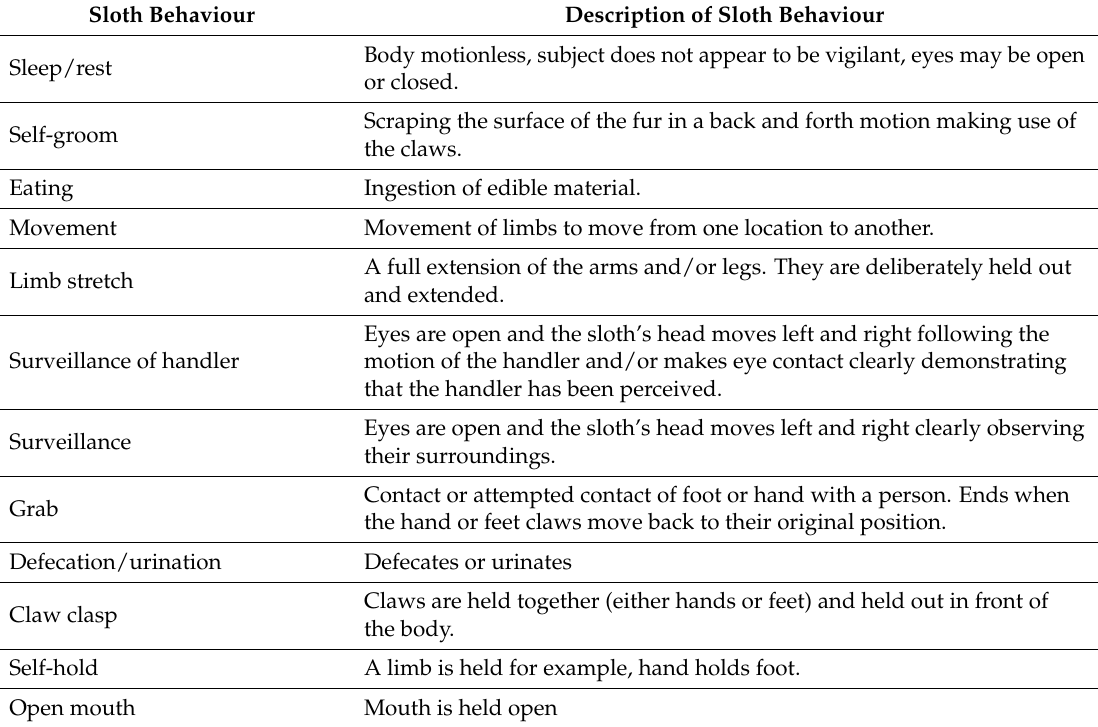
Table 2. Ethogram of behaviours